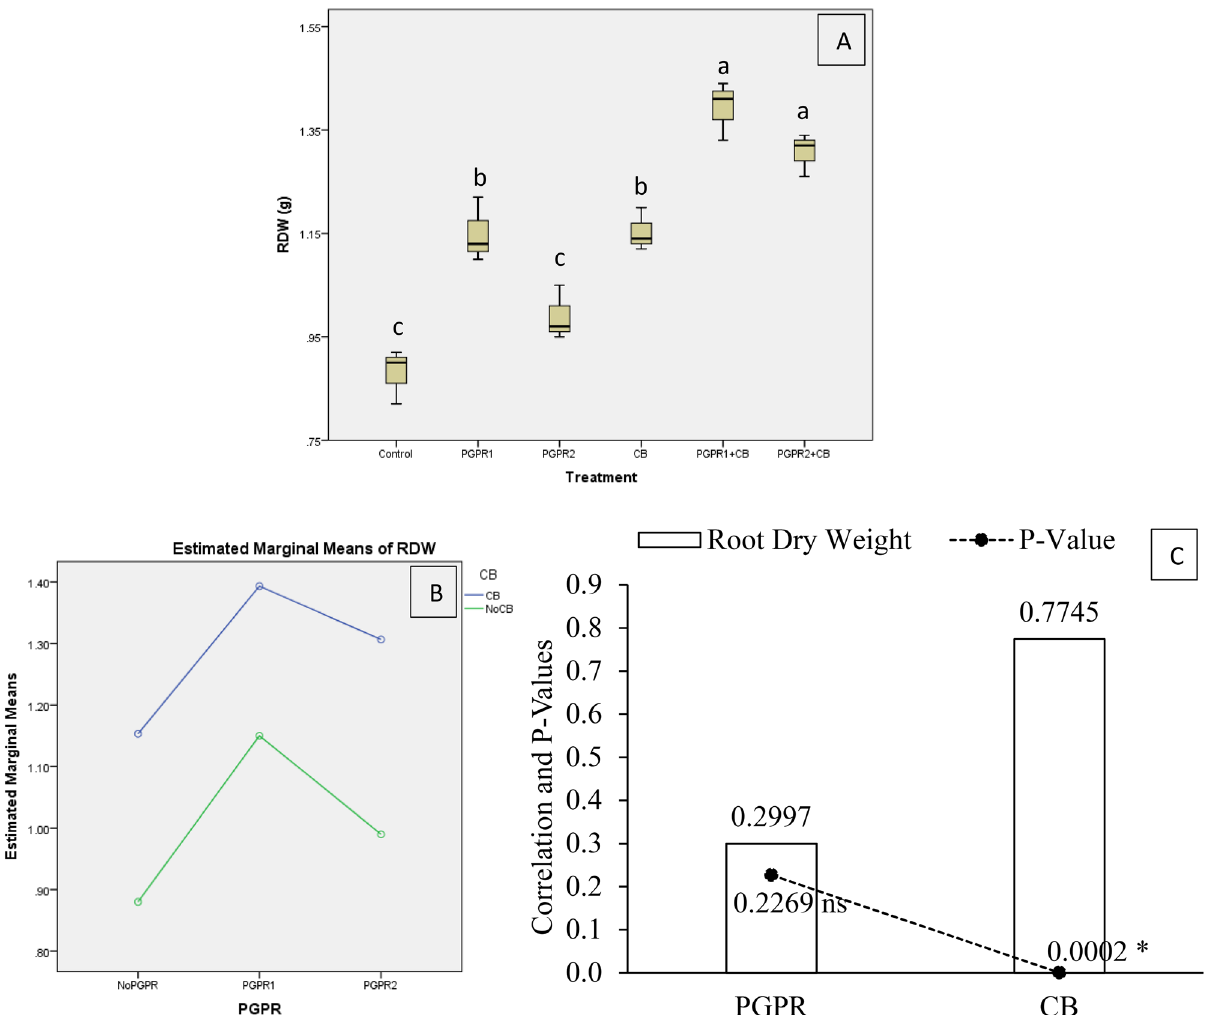
Figure 8. Effect of treatments on mint plants root dry weight (RDW). Values are the average of three replicates ( A ). Different letters showed significant differences (Tukey’s test; p ≤ 0.05). Interaction graph of PGPR and CB for RDW ( B ). Correlation graph of PGPR and CB for RDW ( C